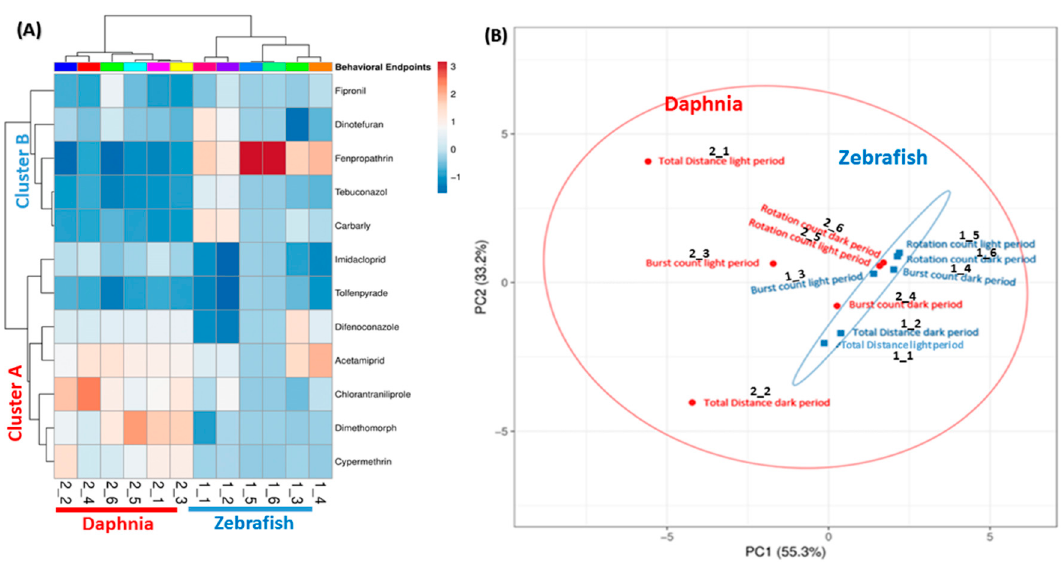
Figure 8. Hierarchical clustering for locomotor activity changes collected from both zebrafish and daphnia based on the pesticide dimension. ( A ) Heat map color key. Color in the heat map represents the deviation from the average of the control: red, higher activity; light blue, lower activity. ( B ) Principal component analysis (PCA) showing the group of pesticides cluster together based on their response to behavior. Unit variance scaling is applied to rows; singular value decomposition (SVD) with imputation is used to calculate principal components. X and Y axis show principal component 1 and principal component 2 that explains 55.3% and 33.2% of the total variance, respectively.